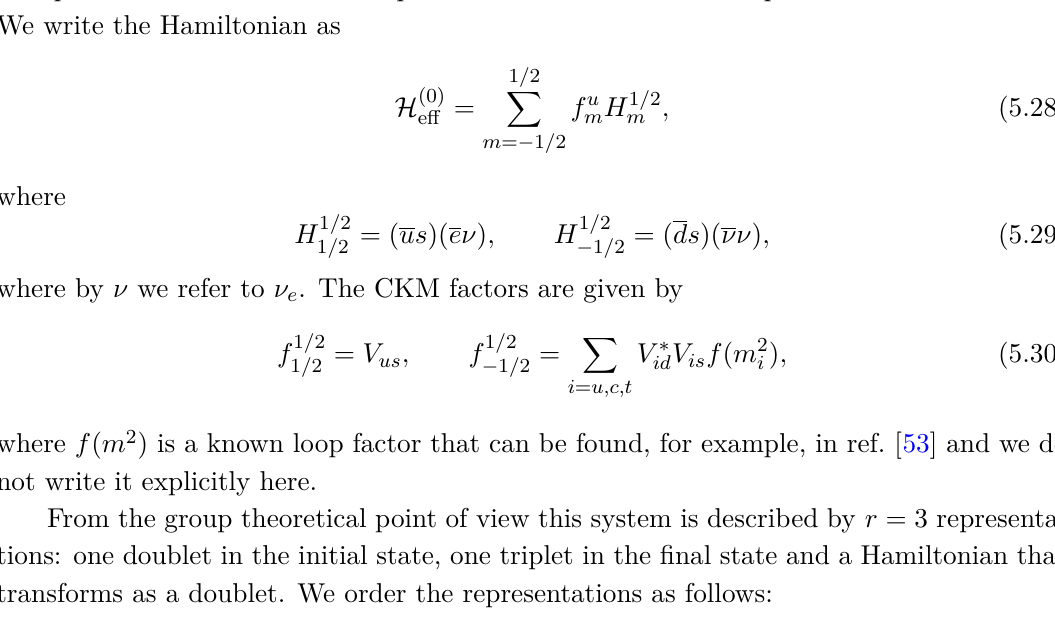
The processes in the K → π isospin-set are realized via an isospin doublet